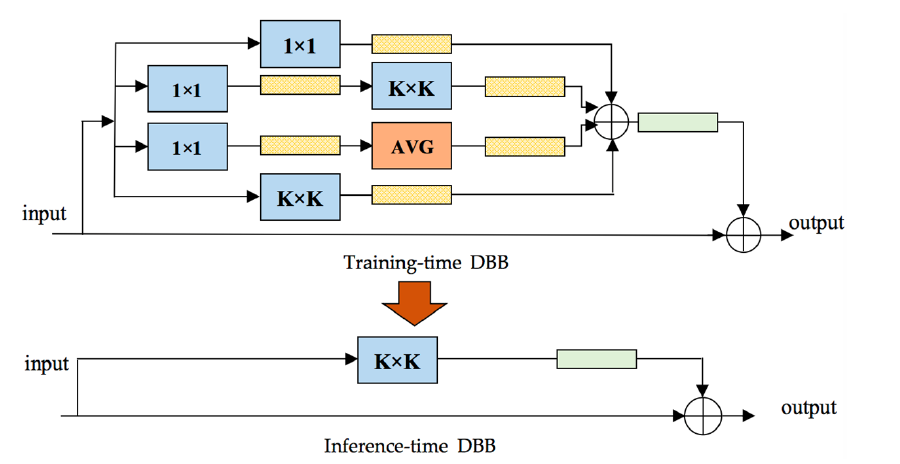
Figure 6. A representative example of DBB.